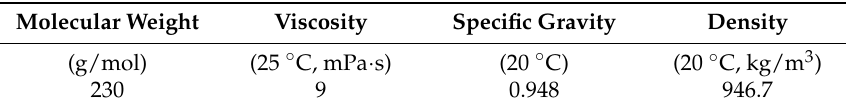
Table 3. Physical properties of the hardener Jeffamine